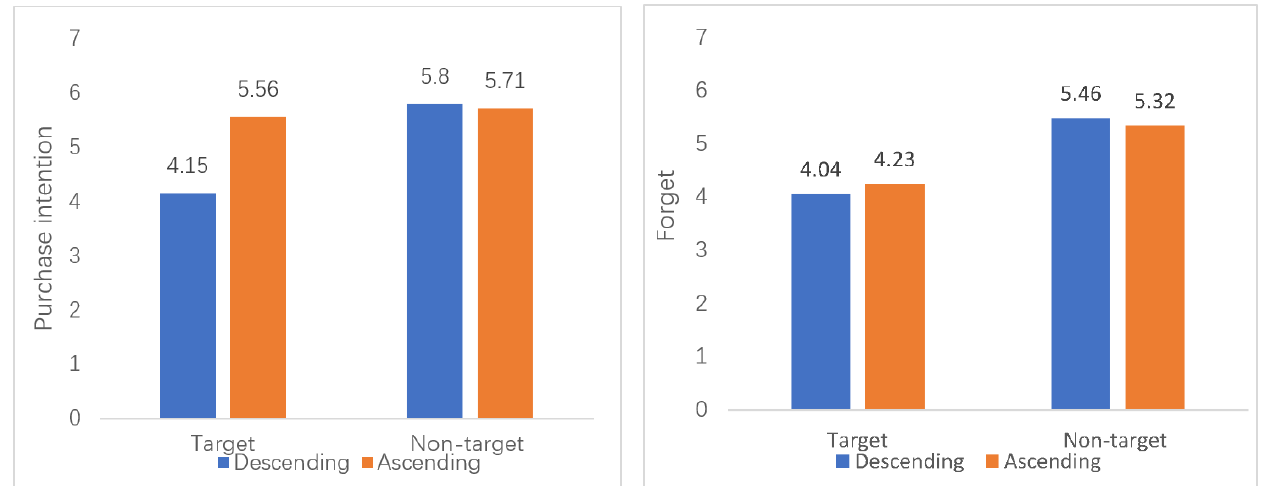
Figure 4. Results of Study 3 on purchase intention and forgetfulness.